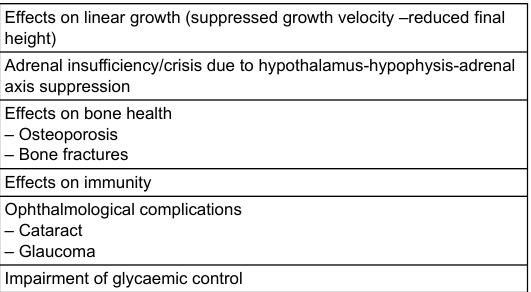
Table 2: Potential systemic adverse effects of inhaled corticosteroids.